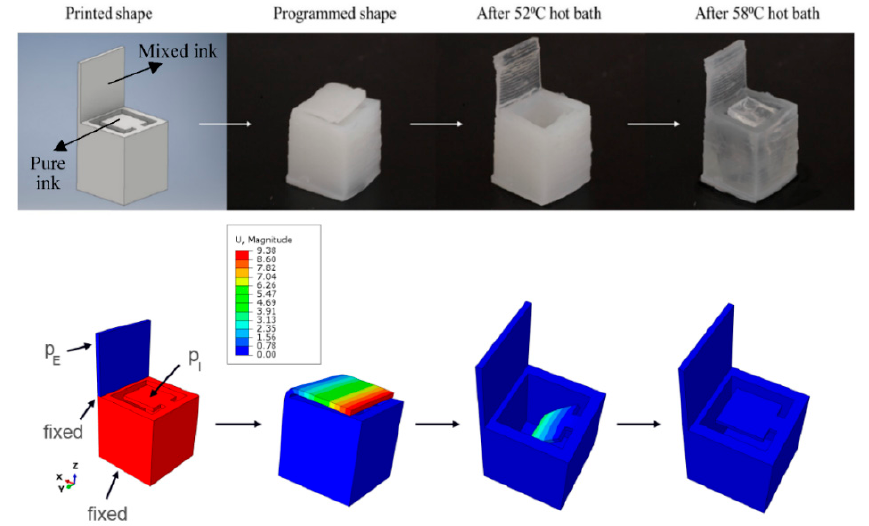
Figure 40. ( Top ) 3D printed box with two lids. The box opens at 52 °C and closes at 58 °C. ( Bottom ) Results of the finite element simulation. Red and blue colors in the first figure on the left denote pure and mixed ink, respectively. Reproduced from [70].